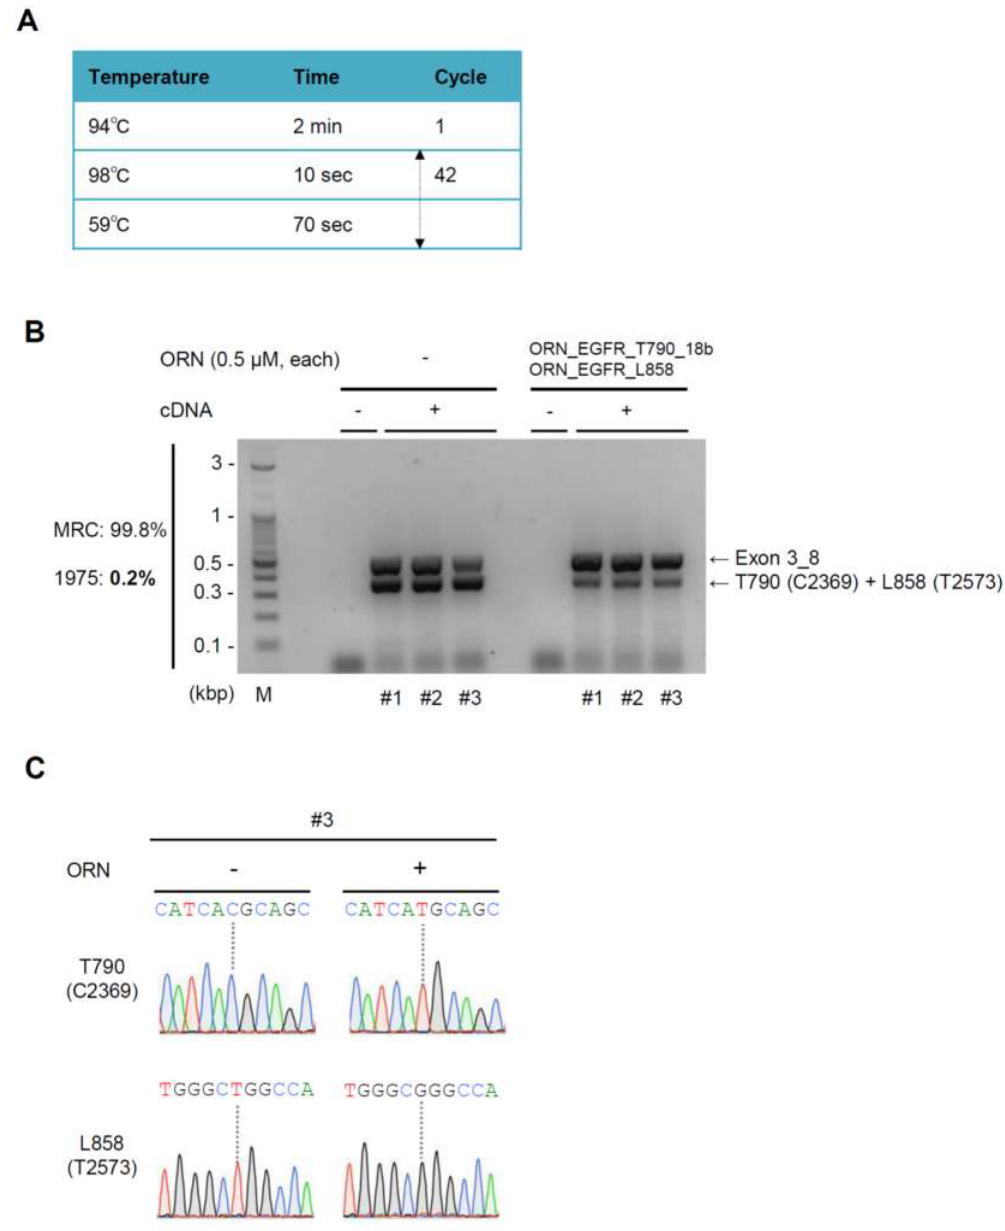
Figure 6. Sensitivity of ORNi-PCR for simultaneous detection of the T790M (C2369T) and L858R (T2573G) mutations in cDNA. ( A ) Conditions for ORNi-PCR with cDNA. ( B ) Results of ORNi-PCR with cDNA. Based on Figure 4F, 0.5 µ M each of ORN_EGFR_T790_18b and ORN_EGFR_L858 were used simultaneously. cDNA reverse-transcribed from RNA extracted from a mixture of MRC-5 cells and NCI-H1975 cells was used for ORNi-PCR in combination with an internal control PCR. Results of triplicate experiments are shown. ( C ) Results of DNA sequencing analysis. PCR or ORNi-PCR amplicons present in ( B ) were subjected to DNA sequencing analysis. Sequencing signals from PCR (#3) and ORNi-PCR (#3) around T790 (C2369) and L858 (T2573) are shown.